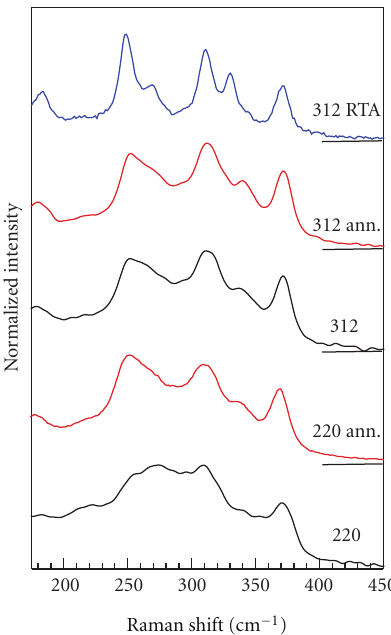
Figure 2: Raman spectra of In 2 S 3 films deposited at 220 ◦ C and 312 ◦ C (220, 312, resp.): black lines. Raman spectra of the same films after one hour annealing at 500 ◦ C in the furnace (220 ann, 312 ann): red lines. Raman spectrum of In 2 S 3 films deposited at 312 ◦ C after 1min. rapid thermal annealing at 500 ◦ C (312RTA): blue line.